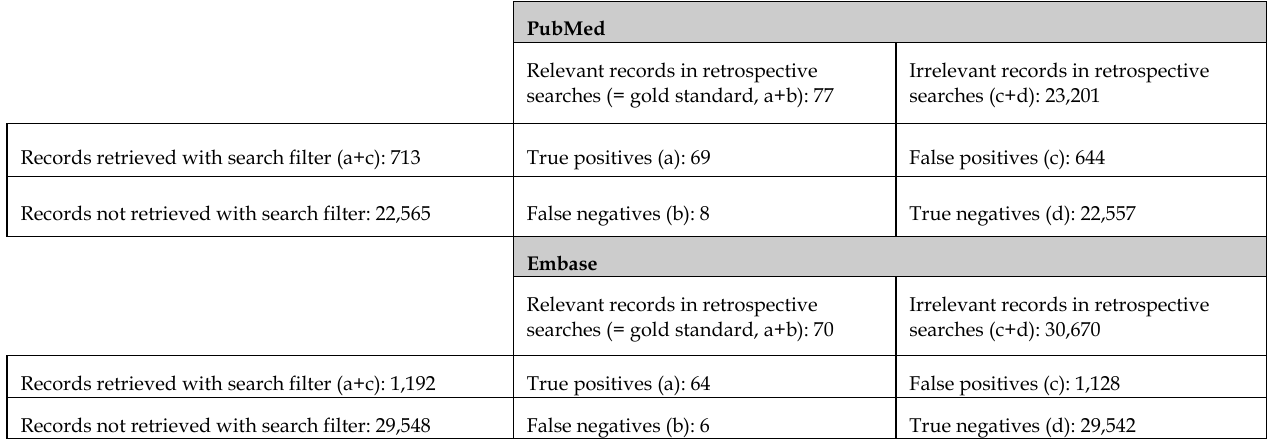
Table 2 Overview of systematic review search filter’s performance in PubMed and Embase